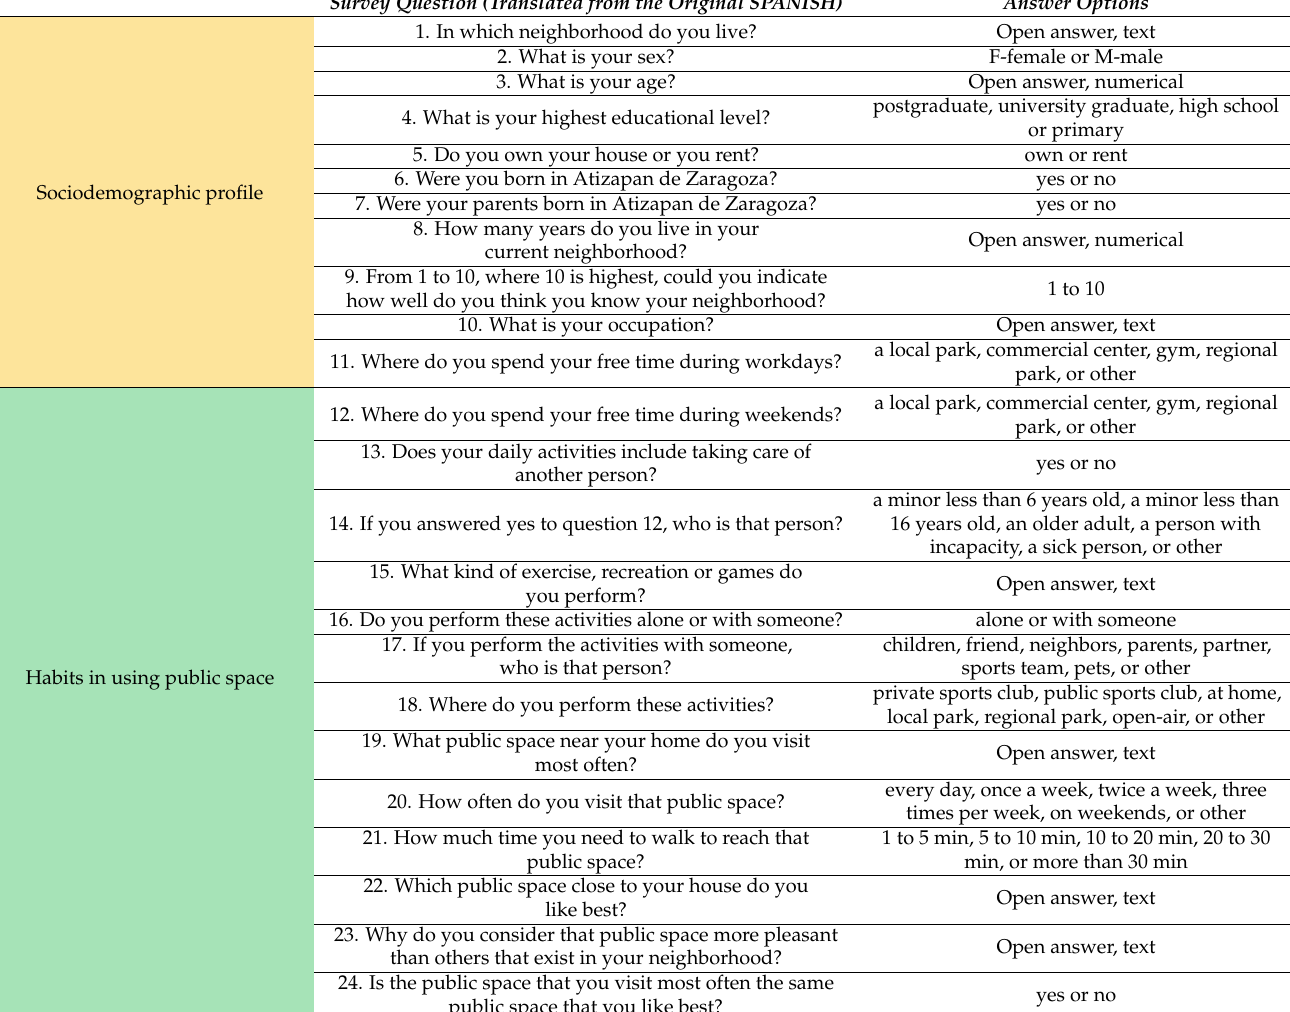
Table A1. The survey developed by students to find preferences in public space